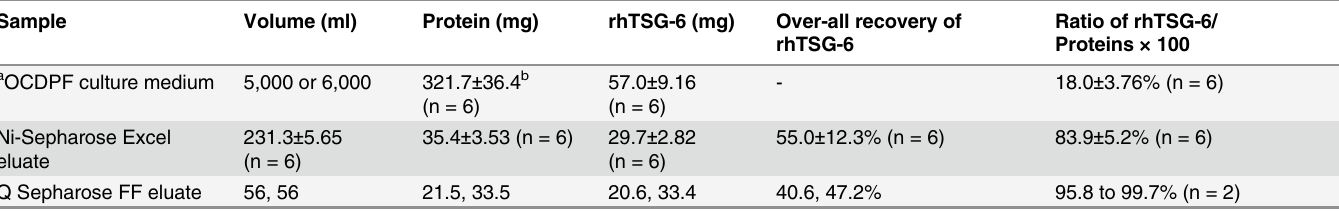
Table 2. Synthesis and Purification of rhTSG-6 in Bioreactor.